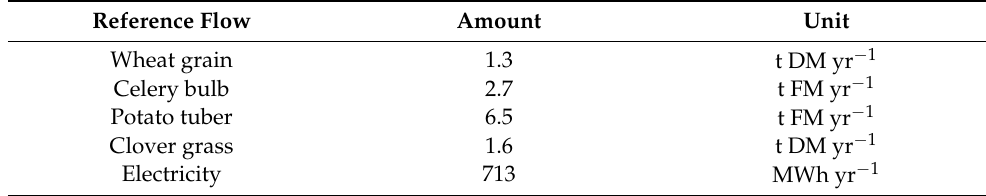
Table 1. Functional unit (FM: fresh matter; DM: dry